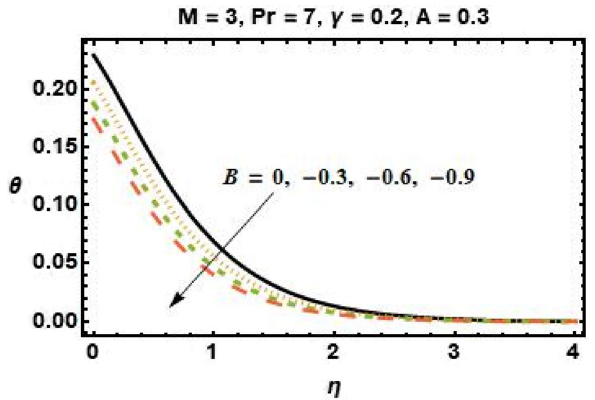
Figure 7. Effects of time-dependent parameter on the temperature profile for B < 0